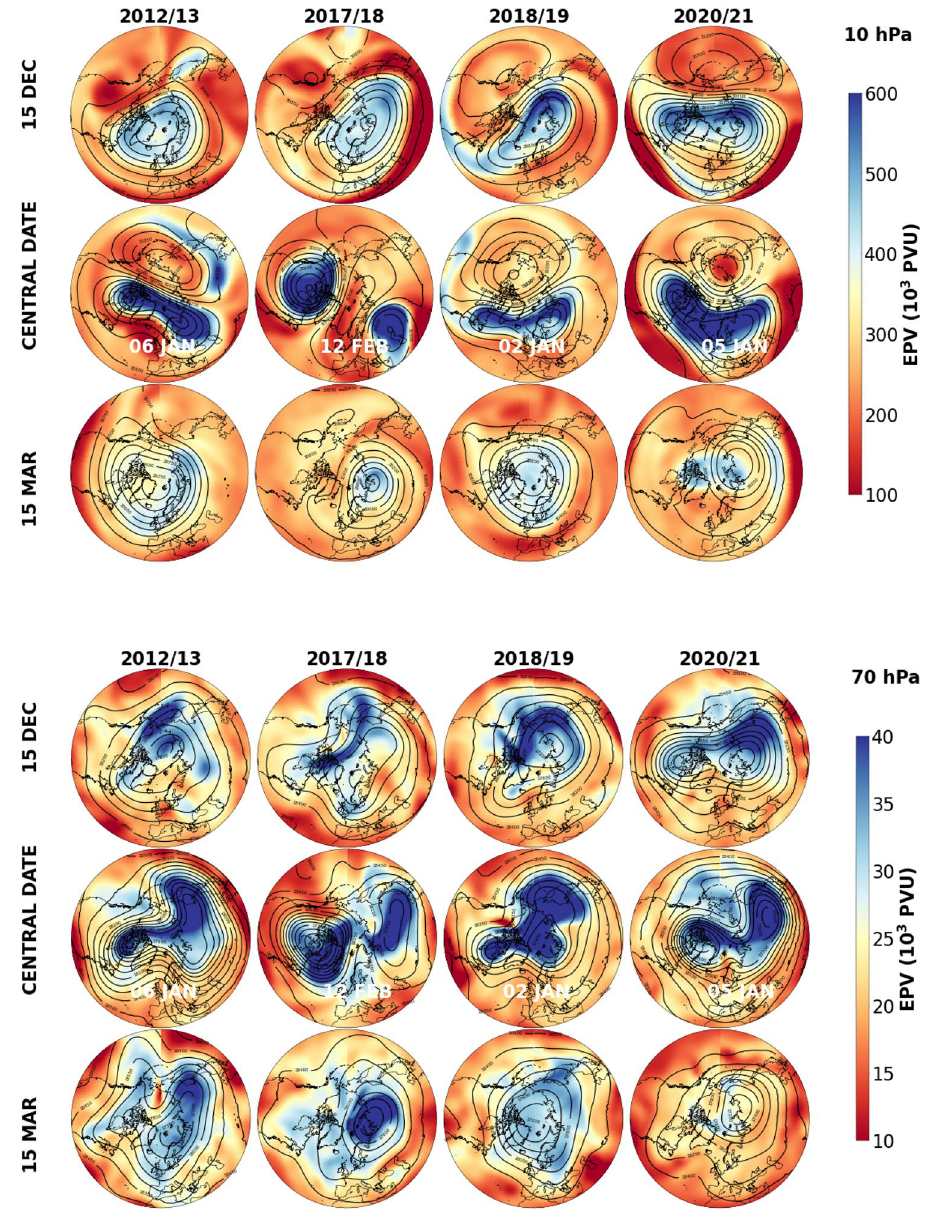
Fig. 3 Maps of potential vorticity (data: MERRA 2) at 850 K ( ∼ 10 hPa/30 km/850 K) for various Arctic winters on 15 December, 15 March, and on the central date, the day on which the westerlies changed to easterlies at 60° N/10 hPa. The overlaid black contours show the geopotential height